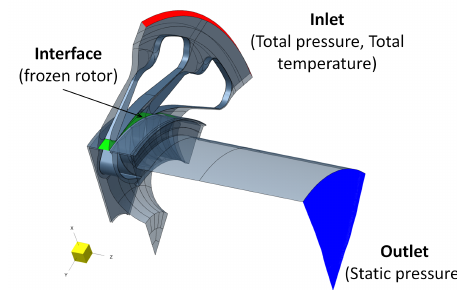
Figure 9. Boundary conditions.